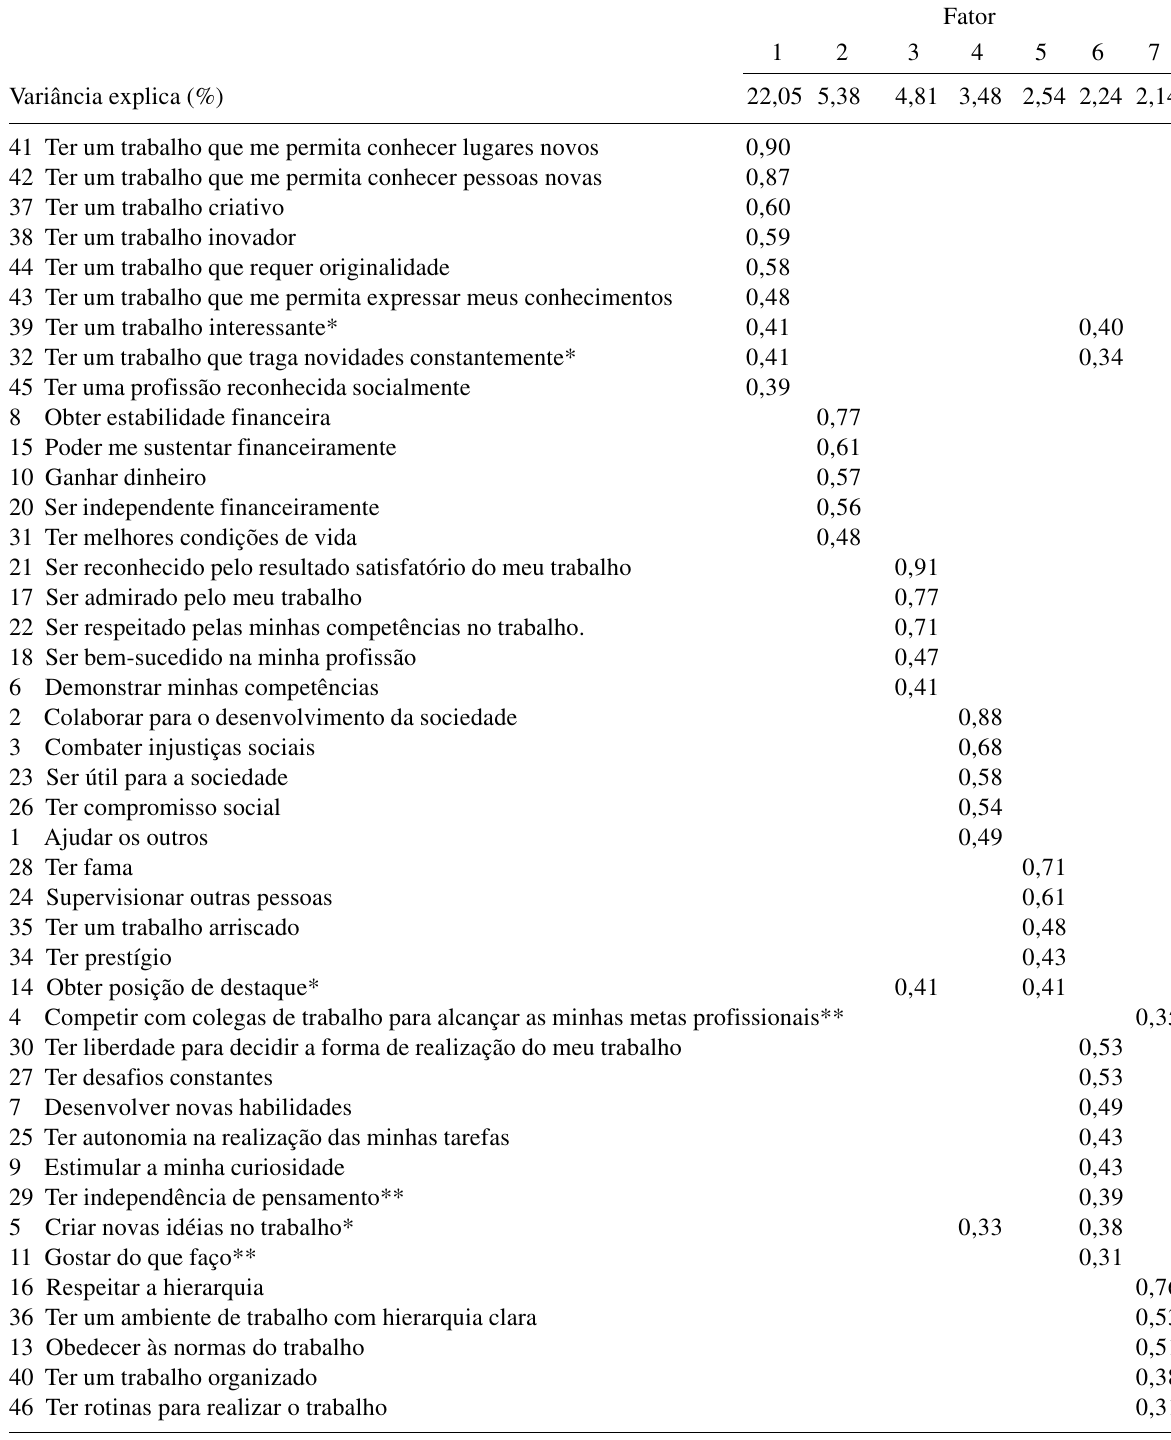
nados da representação gráfica apresentada na Figura